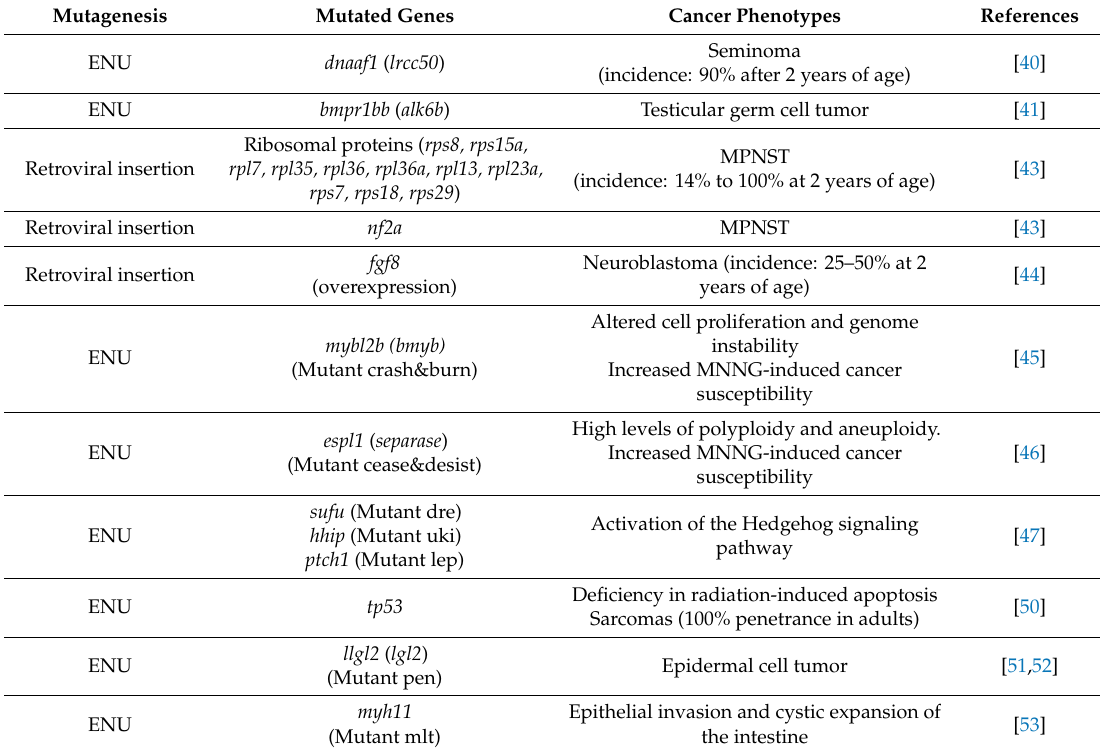
Table 2. Cancer genes identified in zebrafish mutagenesis